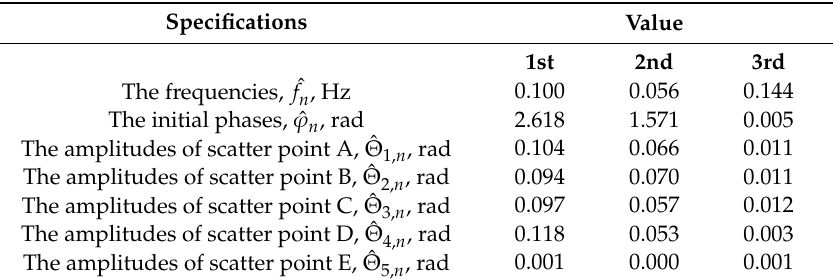
Table 5. The matched values of sinusoidal functions for a rotating ship.